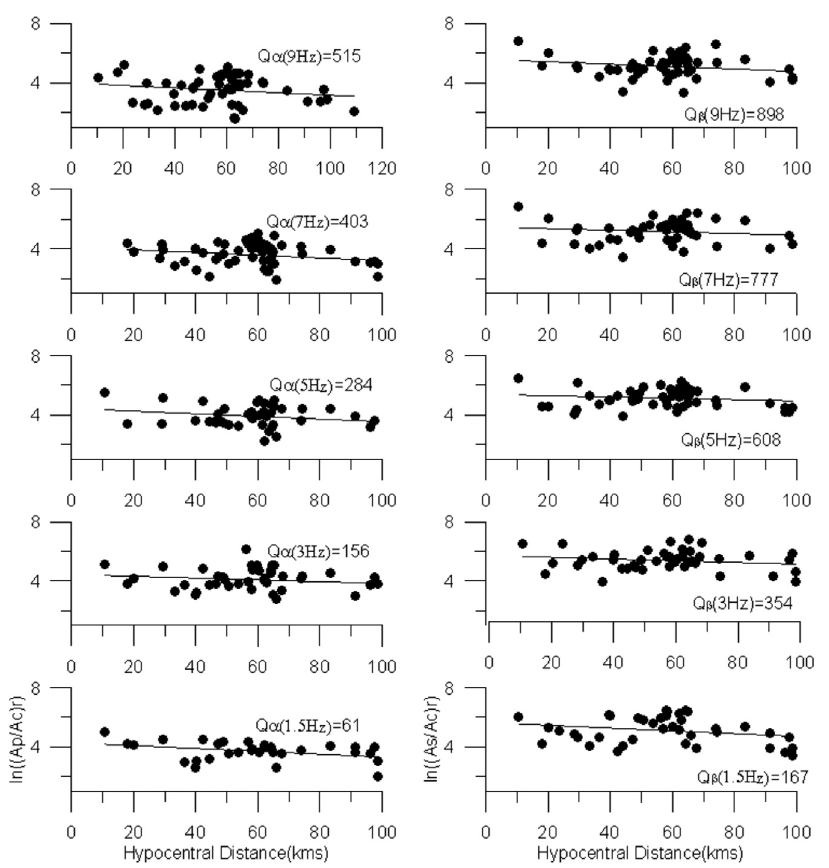
Figure 5. Plot of ln (( As / Ac ) r ) with respect to hypocentral distance r (km) and corresponding plots of S-waves at five different central fre- quencies for NDI station.